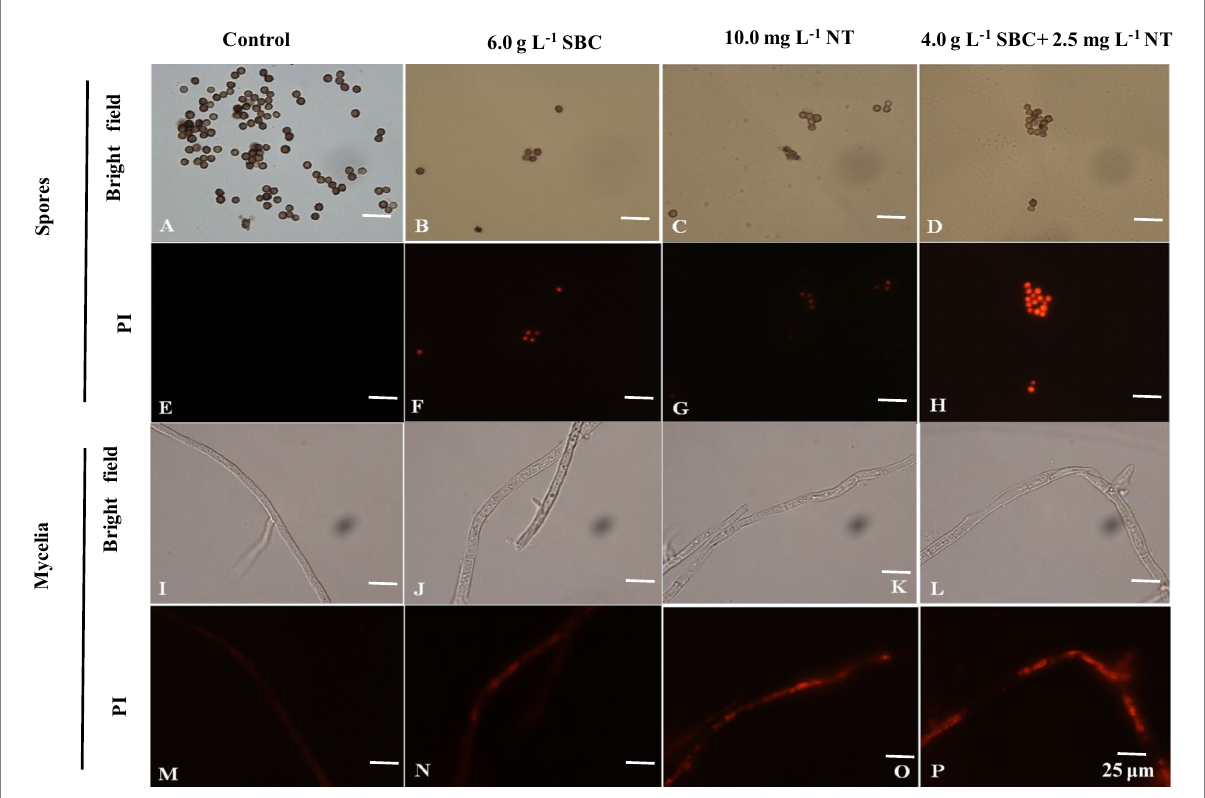
FIGURE 8 Effect of SBC, NT, and combination treatment on the plasma membrane integrity of Aspergillus niger . (A,E) Spores in control; (B,F) spores treated with 6.0 g/L SBC; (C,G) spores treated with 10.0 mg/L NT; (D,H) spores treated with 4.0 g/L SBC + 2.5 mg/L NT; (I,M) mycelia in control; (J,N) mycelia treated with 6.0 g/L SBC; (K,O) mycelia treated with 10.0 mg/L NT; (L,P) mycelia treated with 4.0 g/L SBC + 2.5 mg/L NT mycelia. Images were obtained by microscopy at 1,000× magnification, bar = 25 μ